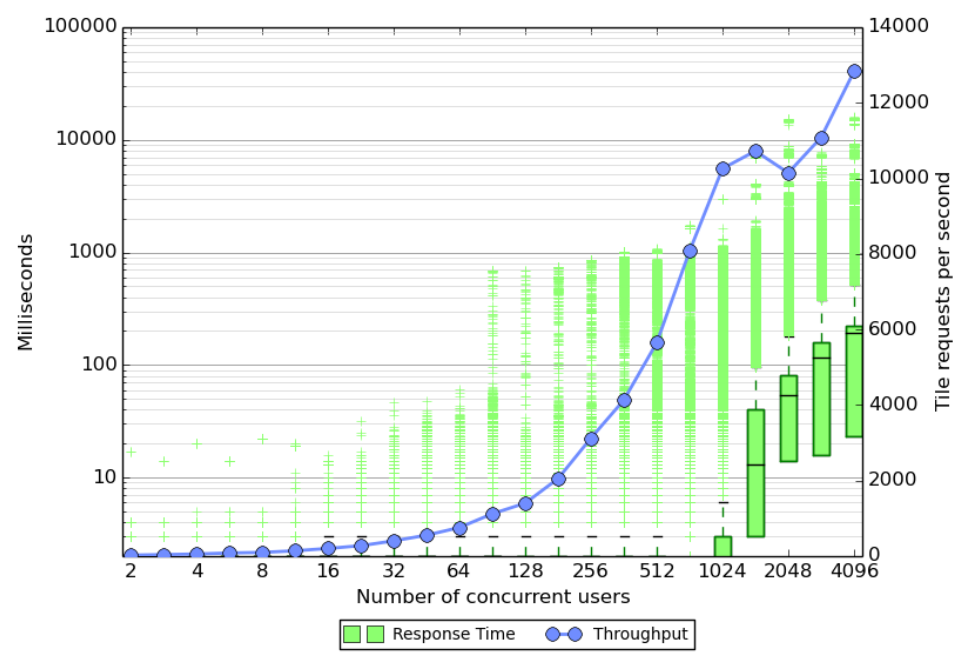
Figure 4. Stress test results for the server with tile caching. Note the logarithmic scale on the left axis. The green response time box gives the median time as a black line with the bottom and top of the box given by the first and third quartiles, respectively. Outliers are shown using a plus sign. The throughput is shown using a linear scale on the right. The stress testing did not cause any failed responses by the map server. The graph was created using a modified version of a python script [29].